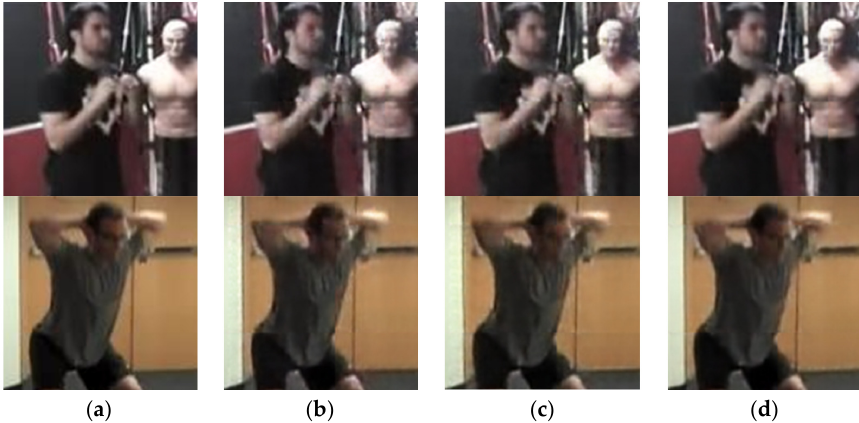
Figure 10. Comparison of various combination of loss functions on the proposed frame interpolation network and the UCF101 dataset. The proposed loss function output is preferable output in human vision. The figures are demonstrated in four columns. From left, they are ( a ) the ground truth, ( b ) the combination of the adversarial loss, L1 loss, and GDL, ( c ) the combination of the adversarial loss, L2 loss, and GDL, and ( d ) the proposed combination of loss function.